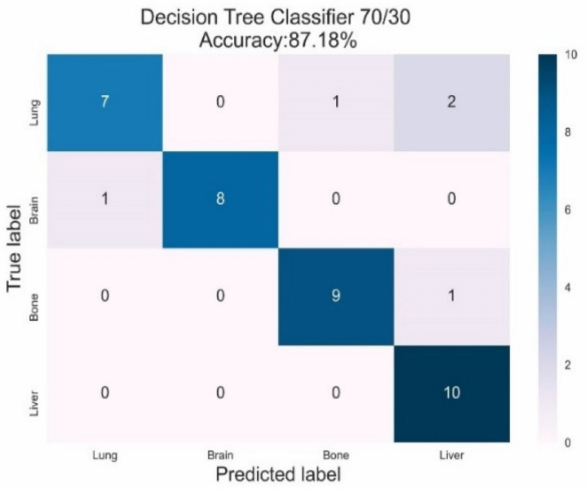
Figure 13. Confusion Matrix (Decision Tree Classifier).